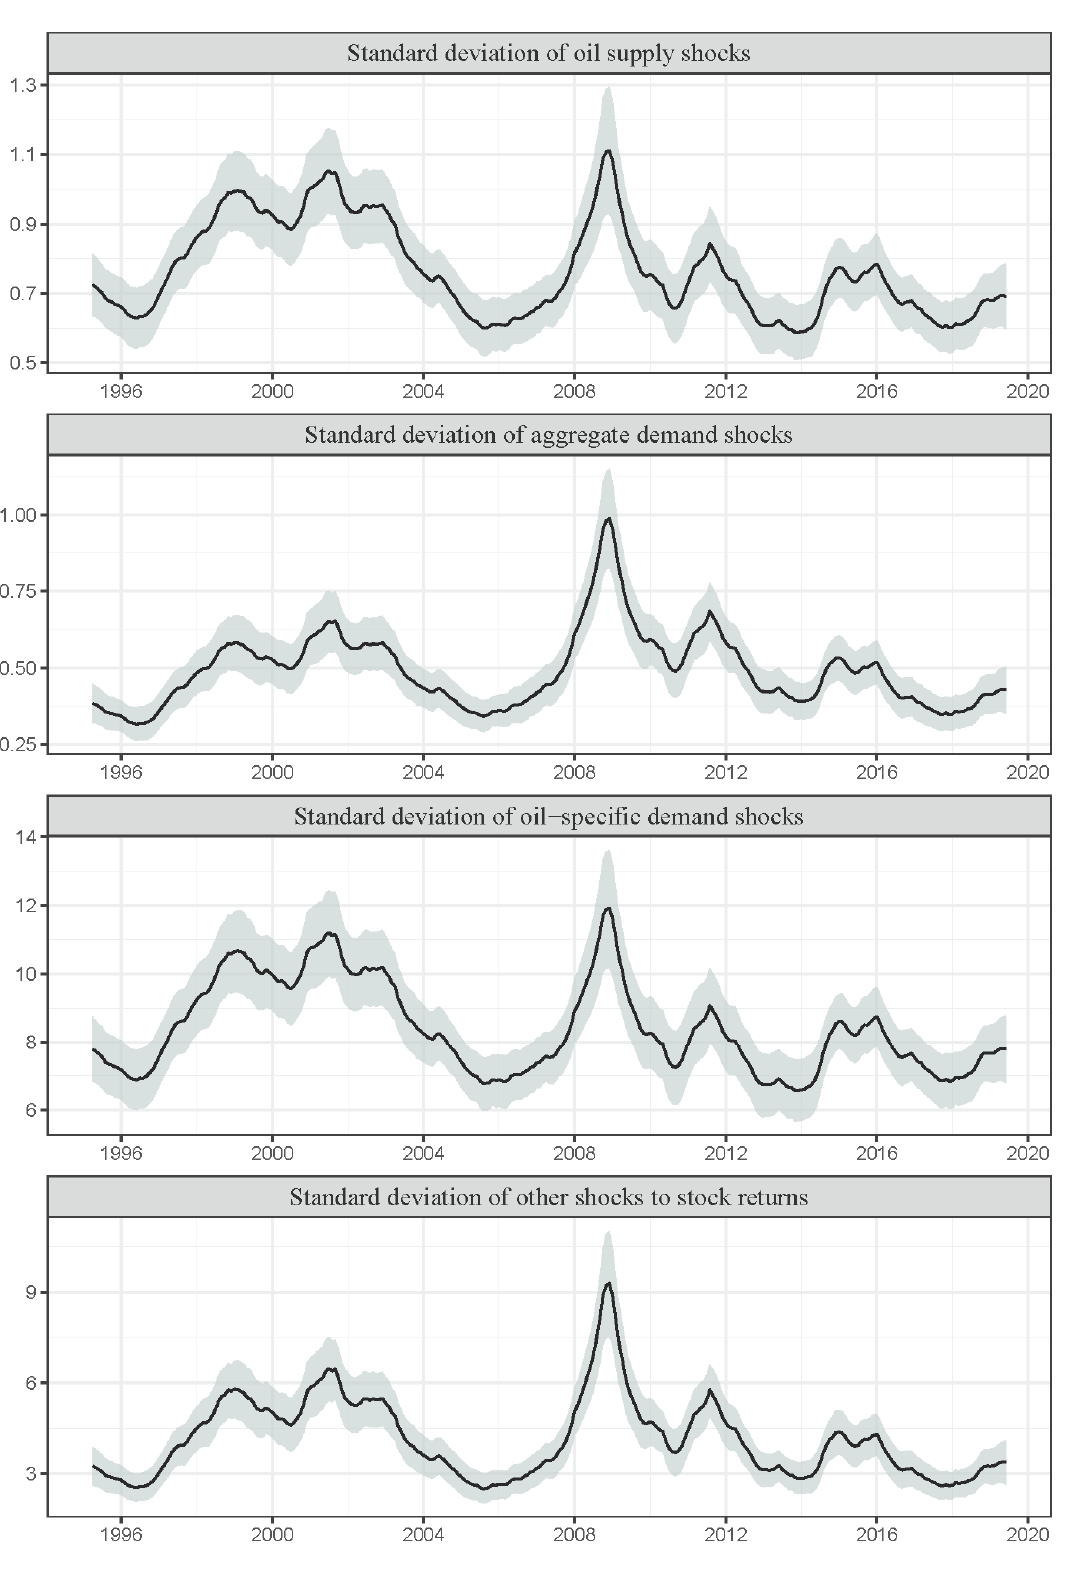
Figure 2. Standard deviations of structural shocks. Note: This figure presents the posterior means and the credible intervals of standard deviations of structural shocks (1995:04–2019:06). The black line shows the mean of the standard deviations while the gray area displays 16th and 84th percentiles. Notice that the scale of the standard deviations is different.